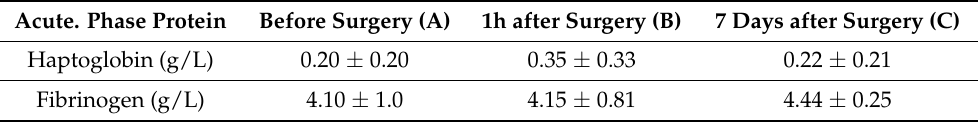
Table 1. Plasma concentration of haptoglobin (g/L) and fibrinogen (g/L) taken from sheep before implantation ( A ), immediately after surgery ( B ), and 7 days ( C ) after surgery. Acute. Phase Protein Before Surgery (A) 1h after Surgery (B) 7 Days after Surgery (C) Haptoglobin (g/L) 0.20 ±